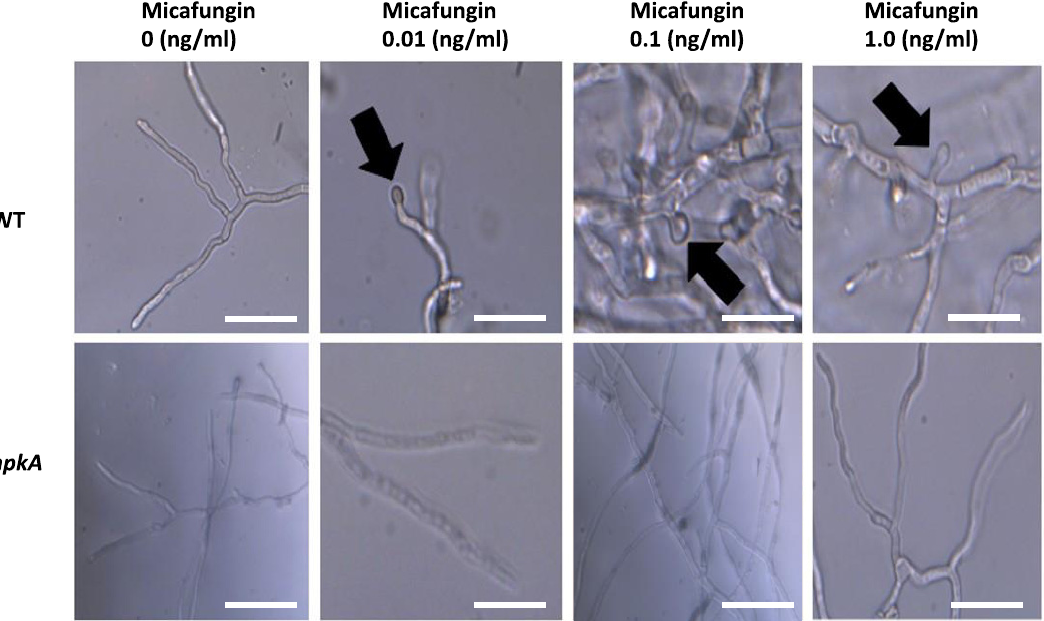
Figure 4. Hyphal morphology following exposure to micafungin. The morphology of wildtype and ∆ mpkA hyphae that were untreated was normal. Wildtype hyphae display bulges at hyphal tips and lateral branches when exposed to micafungin at each tested dosage (black arrows). No morphological differences in ∆ mpkA hyphae following micafungin exposure. 60 × magnification. Scale bar is 25 µ m. Pictures taken on Olympus BX51 microscope.